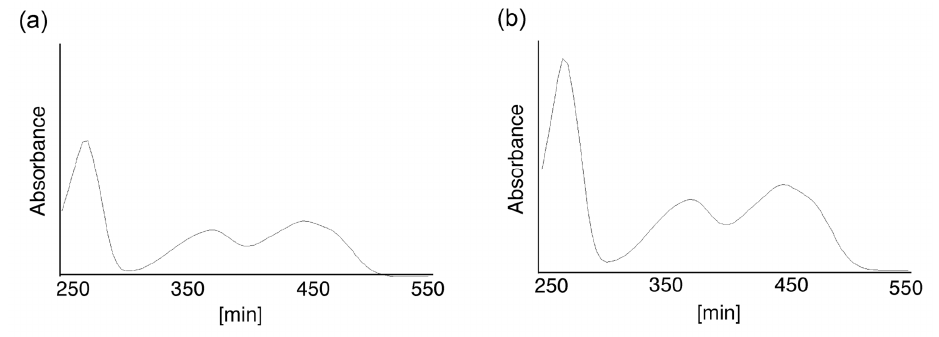
Figure 2. The UV-vis spectrum of flavin-CG ( 2 ). The UV-vis spectra of the major peaks at ( a ) 19.9 min and ( b ) 20.5 min in Figure 1 were determined.